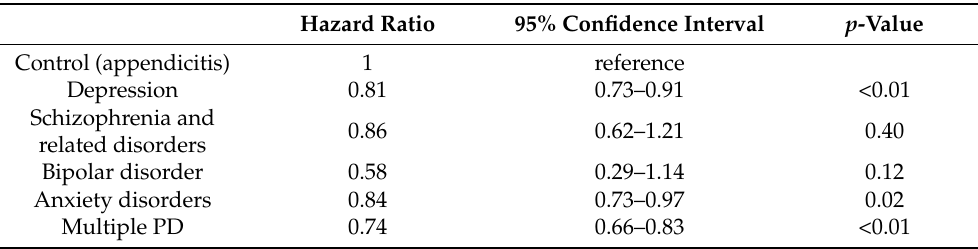
Figure 2. Competing risk estimates of the effect of having a psychiatric diagnosis on the risk of developing a tobacco- related cancer. Table 3. Competing risk model used to estimate the effect of having a PD on the risk of developing a TR cancer in light of the competing risk of mortality.